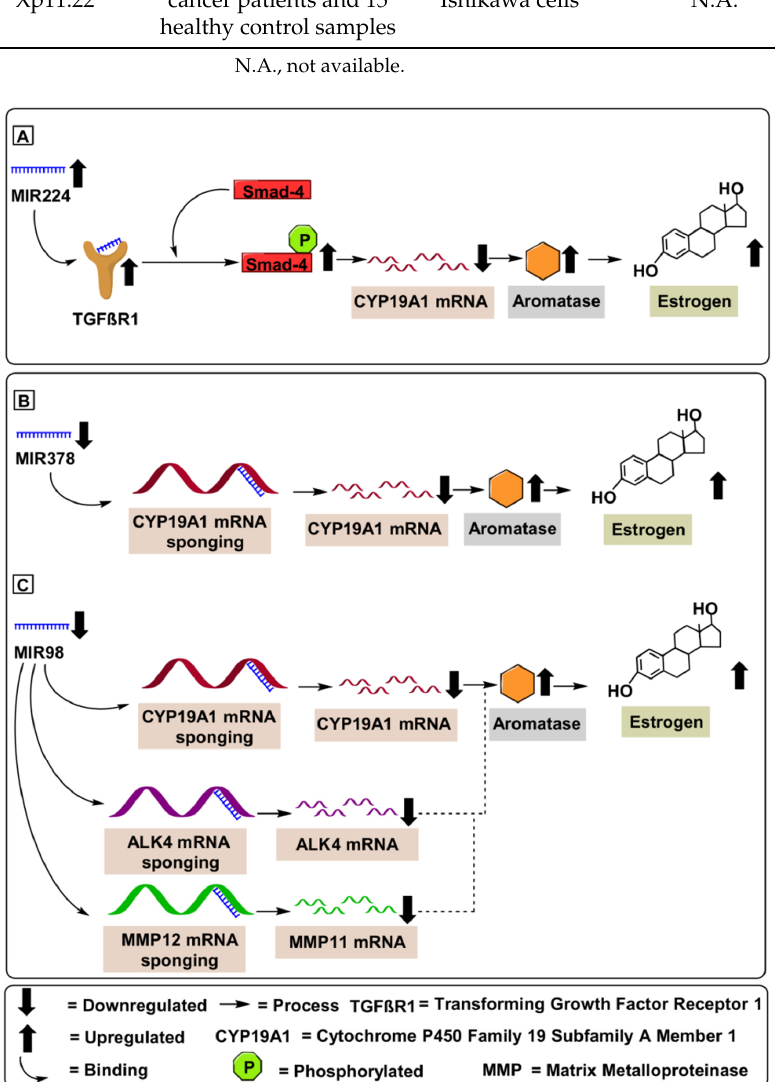
Figure 6. MicroRNAs involved in aromatase regulation in ovarian cancer. ( A ) Oncogenic expression of MIR224 enhances TGF- β 1protein levels, inducing GC proliferation by targeting Smad4 protein, leading to a subsequent increase in the CYP19A1 mRNA levels. ( B ) Tumor suppressive role of MIR378 downregulates CYP19A1 mRNA levels in ovarian cancer patients. ( C ) Tumor suppressor role of MIR98 downregulates CYP19A1 mRNA levels in ovarian cancer patients furthermore, MIR98 was found to bind to the 3’-untranslated region of ALK4 and MMP11 mRNA induced differentiation and cell proliferation. MIR378, annotated as MIR-378, MIR 378, miRNA378, hsa-mir-378, and hsa-mir-378a, is located on chromosome 5q32 [76,77] and its overexpression has been correlated with inhibited cell proliferation and induced apoptosis [80]. Mechanistically, MIR378 inhibits